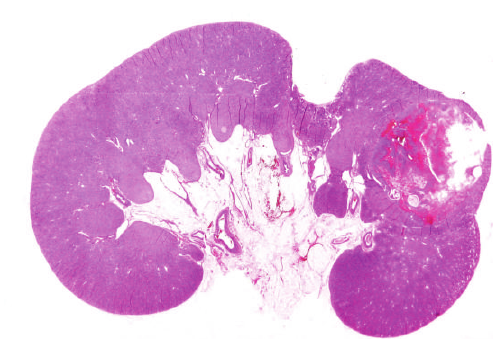
Figure 8: Example of large format section of a case of clear cell carcinoma of the kidney. The relationship with the tumour and the surrounding tissue, capsule, and urinary pelvis are well evident. In addition the renal parenchyma shows an area of pyelonephritis.